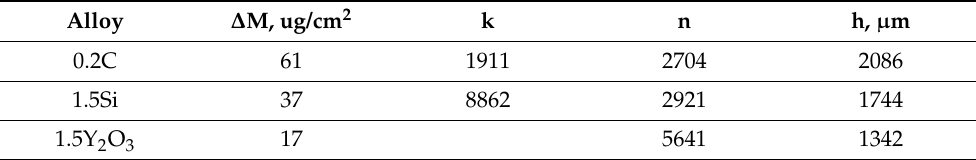
Figure 8. The oxidation kinetic curves after isothermal annealing at 1100 °C. Table 4. The oxidation kinetics characteristics of the 0.2C, 1.5Si, and 1.5Y 2 O alloys at 1100 °C and the values of the oxide layer thickness (h) after 30 h of isothermal holding.